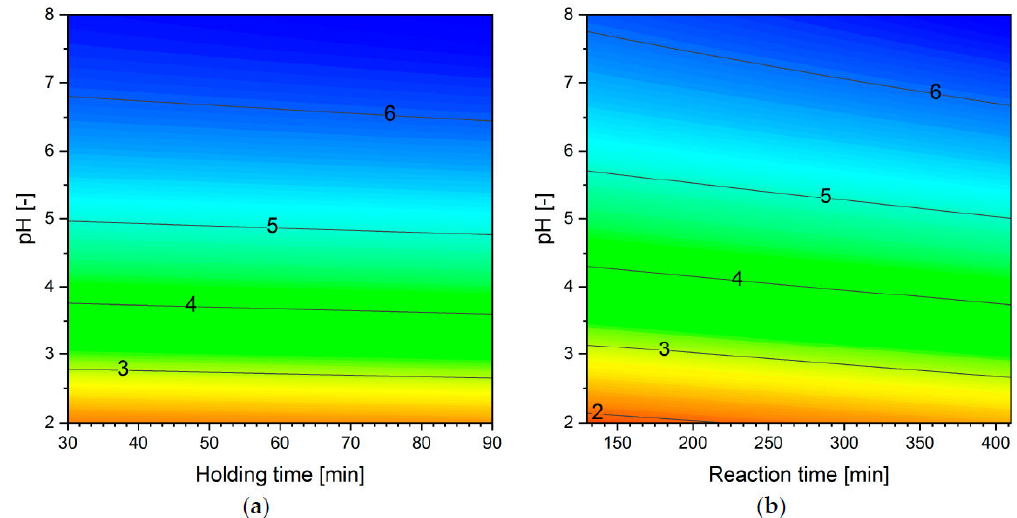
Figure A3. Regression model contour plots showing the dependence of the process water pH (-) on initial pH and ( a ) holding time and ( b ) reaction